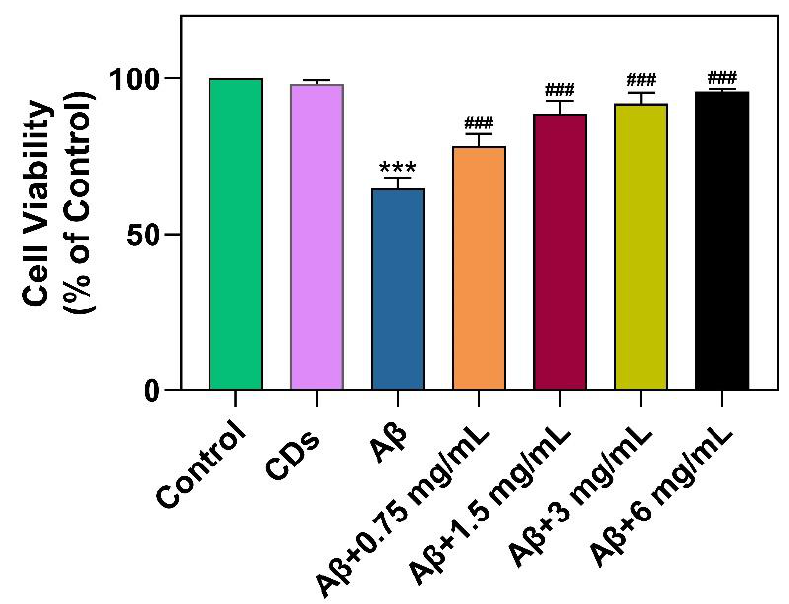
Figure 6. Effect of A β 1–42 peptide (100 µ M), N-CDs (6 mg/mL), or A β 1–42 (100 µ M) mixed with N-CDs at the concentration of 0.75, 1.5, 3, and 6 mg/mL on the viability of N2a cells after 24 h of incubation. (*** p < 0.001 vs. Control; ### p < 0.001 vs. purely A β 1–42 -treated group).